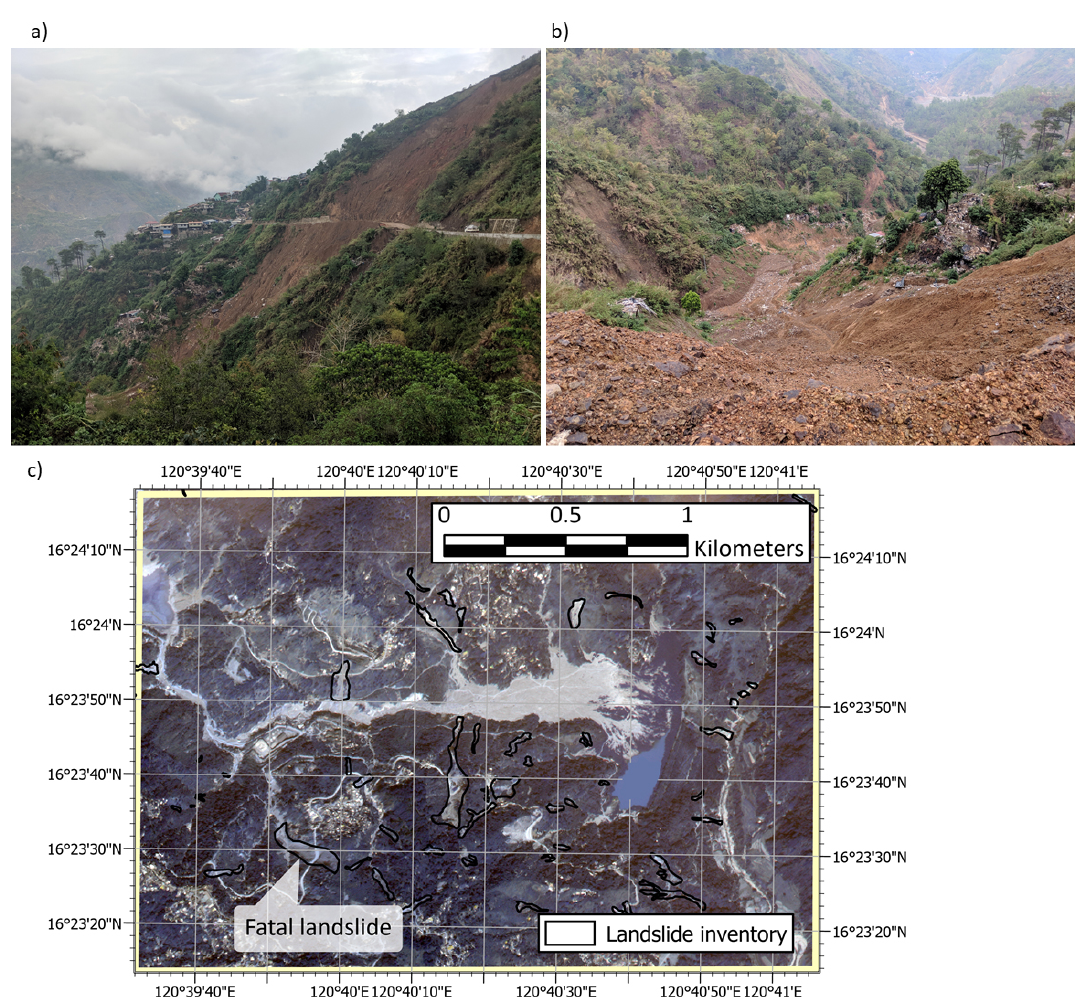
Figure 5. (a) General view of the initiation area of the fatal landslide in Barangay Ucab that killed more than 80 miners; (b) view of the particularly long runout of the landslide, from the road facing downhill; and (c) location of the landslide (see yellow rectangle in Fig. 1 for the exact location within the study area). Satellite imagery from WorldView (2 March